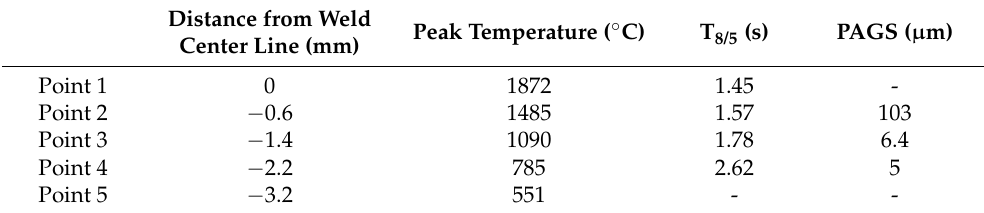
Table 4. Peak temperature, t 8/5 and PAGS at different